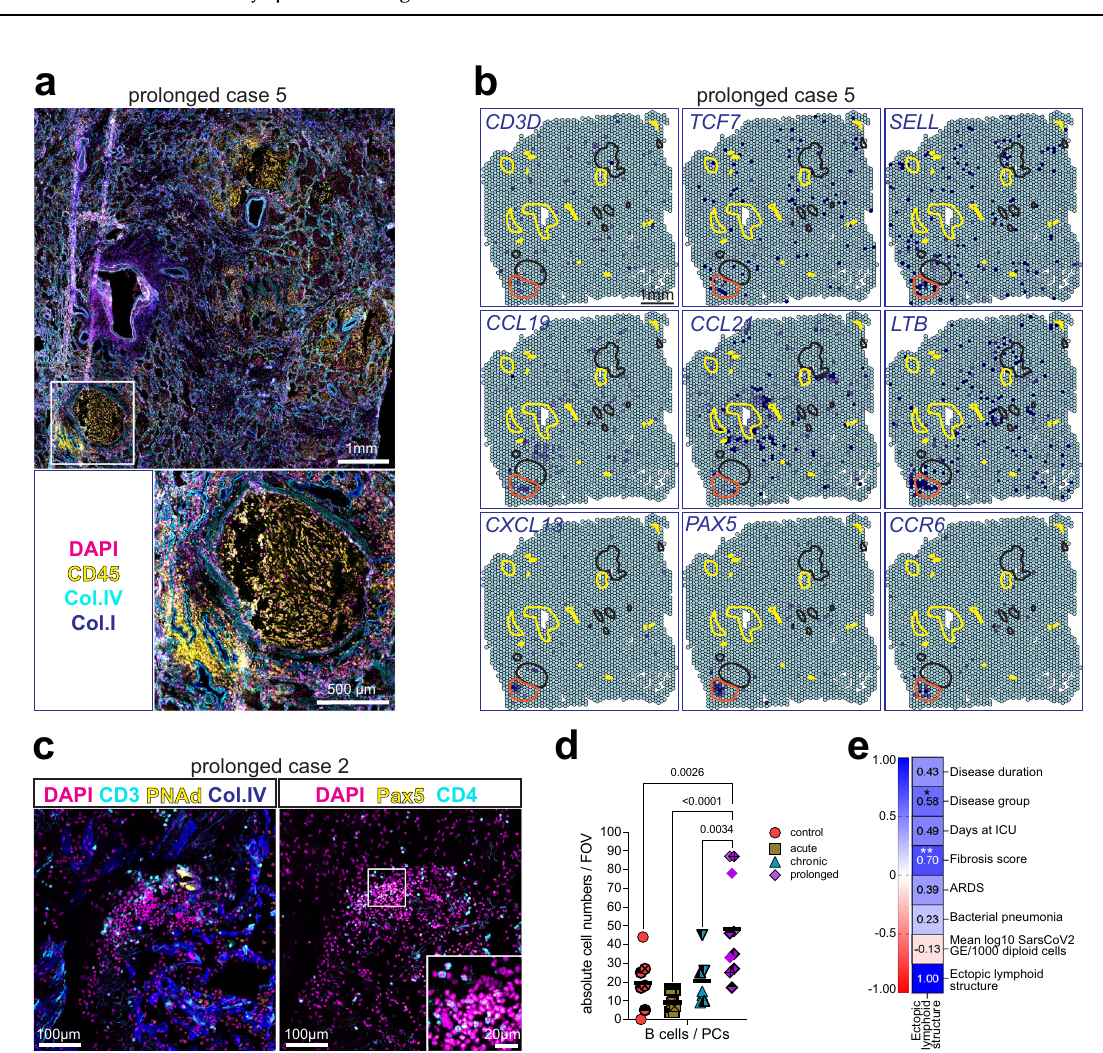
Fig. 4 | Activated lung adventitial niches host CCR7 + exhausted T cell aggre- gates in prolonged COVID-19. a Immuno fl uorescence (IF) overlay depicts CCR7 (yellow), CD3 (cyan), α SMA (blue) and CD31 (magenta) in a prolonged COVID-19 lung.Whitesquaredepictsregionofinterest(ROI),whereenlargedsinglechannels are shown, together with PD1, Ki67 and DAPI ( n =8 FOVs). See also Supplementary Fig. 4a. b Dot plot representation of absolute counts of CD4 + and CD8 + T cells and NK cellsanalyzedby multiplexmicroscopy. Data (M±SD) are analyzedby two-way ANOVAwithFisher ’ sLSD test, F (3,84)= 29.56, p ˂ 0.0001.See also Supplementary Fig. 2a – c, Supplementary Movie 4 and 5. c Dot plot showing protein expression of CD4 + and CD8 + T cells inlungs and lymphnodes of COVID-19 donorsand controls. Color code indicates average mean fl uorescence intensity (MFI) for each marker and dot size indicates percent expressed. d Violin plots show expression level of relevantmarkersinCD4 + andCD8 + Tcellsinlymphnodeandlungsforeachdisease